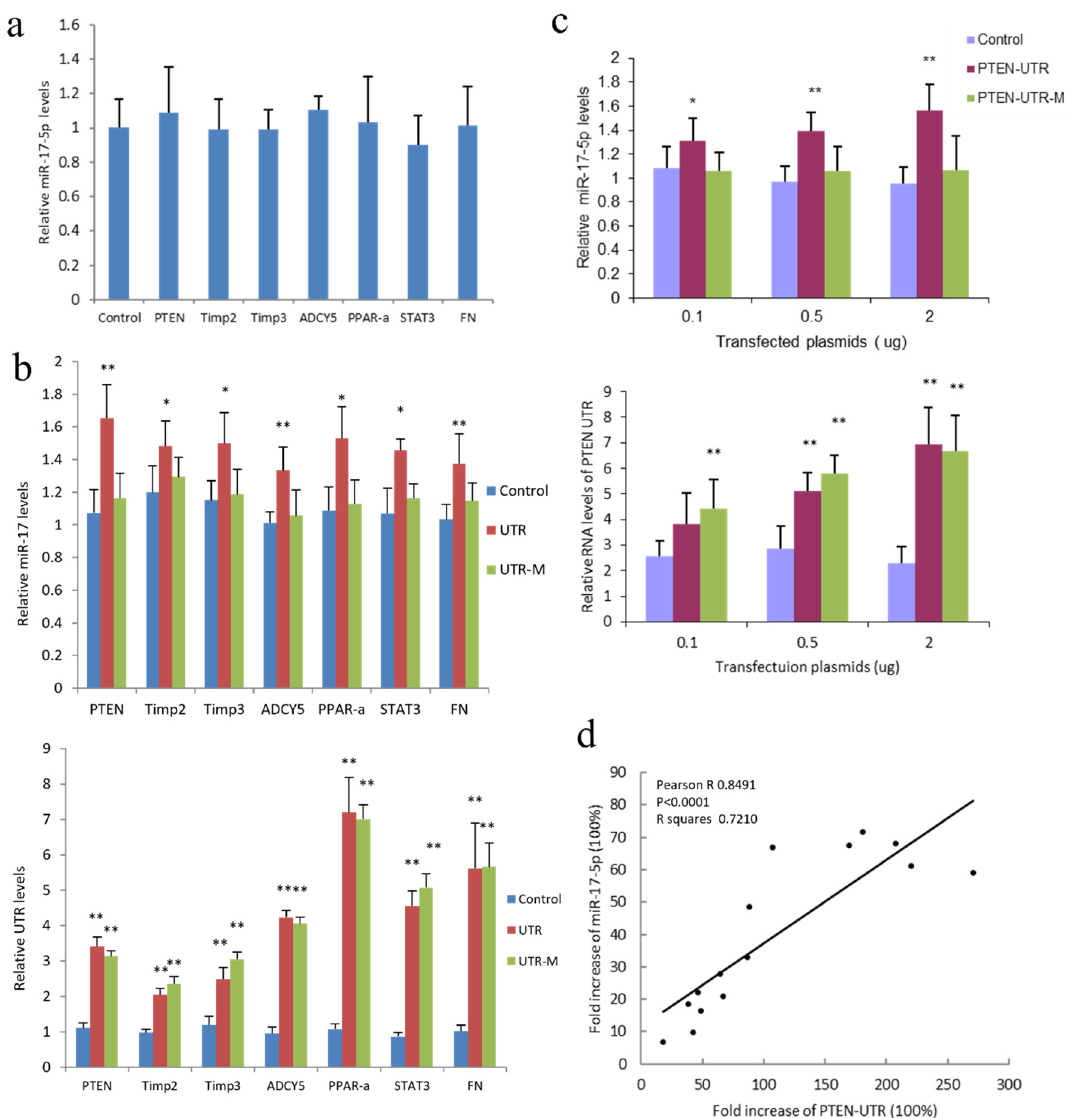
Figure 2. Expression of PTEN 3 ′ UTR increased miR-17-5p levels. ( a ) Hepatocellular carcinoma cell line HepG2 cells were transfected with plasmids of coding sequences of miR-17-5p target genes PTEN, Timp2, Timp3, ADCY5, PPAR- α , STAT3, and Fibronectin (FN), and subjected to RT-PCR. Expression of these miR-17-5p target gene coding sequences did not significantly change miR-17-5p expression levels. ( b ) Upper, HepG2 cells were transfected with plasmids with 3 ′ UTR sequences (UTR) of above miR-17-5p targeting genes and 3 ′ UTR with mutated miR-17-5p binding sites (UTR-M), then subjected to RT-PCR. Expression of 3 ′ UTR sequences of these miR-17-5p target genes, but not 3 ′ UTR with mutated miR-17-5p binding sites, significantly increased miR-17-5p expression. Lower, the expression of the above 3 ′ UTR sequences in the transfected cells. * p < 0.05, ** p < 0.01 vs. control; Error bars, SD; n = 5. ( c ) Upper, HepG2 cells were transfected with a plasmid with PTEN 3 ′ UTR (PTEN-UTR) and PTEN 3 ′ UTR with mutated miR-17-5p binding sites (PTEN-UTR-M) in varying concentrations. PCR showed that expression of PTEN-UTR, but not PTEN-UTR-M increased miR-17-5p levels, which was dose-related. Lower, the expression of PTEN 3 ′ UTR in the transfected cells. * p < 0.05, ** p < 0.01 vs. control; Error bars, SD; n = 5. ( d ) Pearson correlation between fold increases of PTEN UTR and miR-17-5p in the PTEN UTR-transfected HepG2 cells was analyzed by Prism 8. Fold increases of PTEN 3 ′ UTR were positively correlated with increasing miR-17-5p levels. Pearson R = 0.8491; p < 0.0001; n = 15.